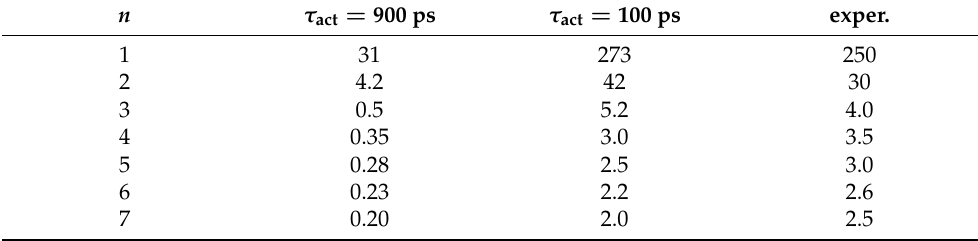
Table 1. P GGG / P G yield ratios of oxidative damage at GGG and G sites for the oxidized 5 (cid:48) -GGG(T) n G- 3 (cid:48) DNA sequences predicted by using the kinetic model of Figure 1, together with τ act = 900 ps (first column, present estimate), and τ act = 100 ps (second column, ref [34]). Experimental values ([26]) are reported in the third